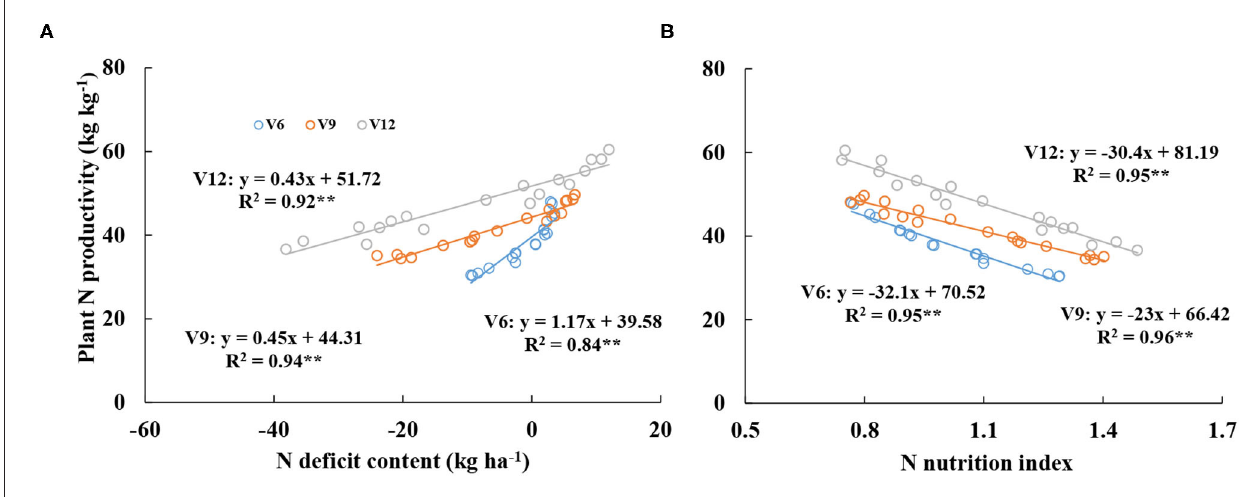
FIGURE 6 | Relationships between plant nitrogen productivity and nitrogen deficit content (A) and nitrogen nutrition index (B) from V6 to V12 stages of corn during the 2015–2016 growing seasons (experiments 1–4).